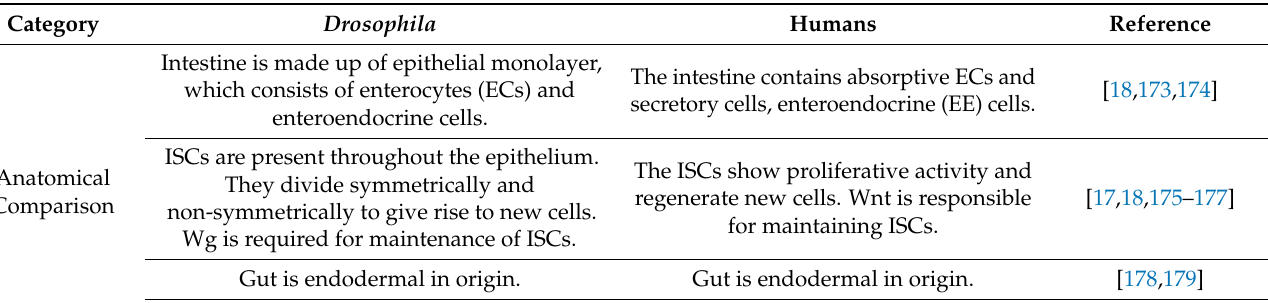
Table 1. Comparison between fly and human